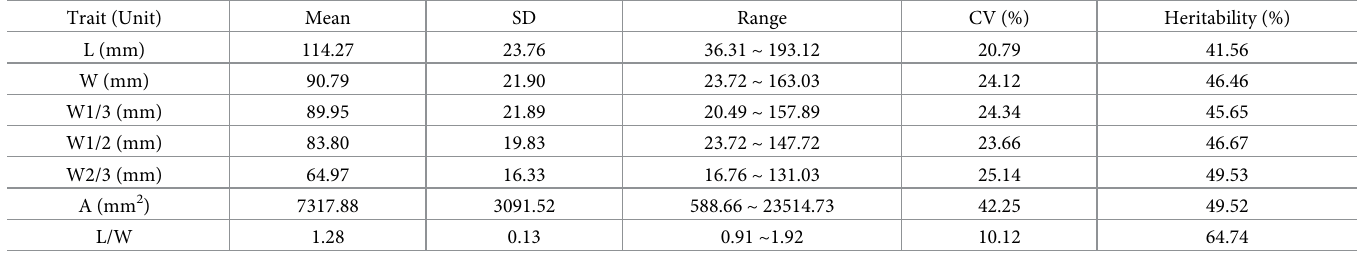
Table 1. Variation in leaf length, different leaf widths, leaf area, and the ratio of length/width in the F 1 progeny of Populus deltoides × Populus simonii based on a randomized complete block design. Trait